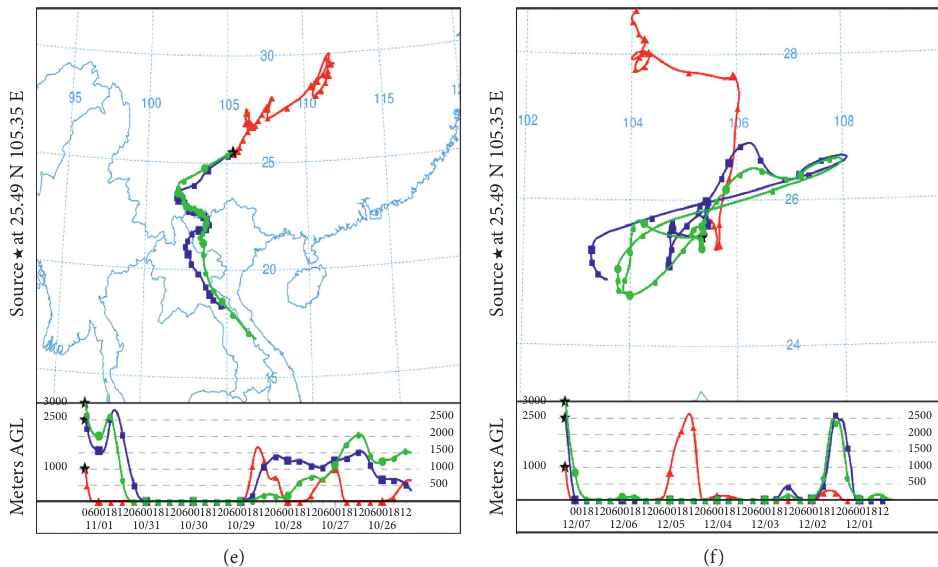
Figure 4: Backward trajectory of water vapor at different time in the Guanling region. (a) 2016-4-14. (b) 2016-5-27. (c) 2016-8-7. (d) 2016-8- 29. (e) 2016-11-1. (f)